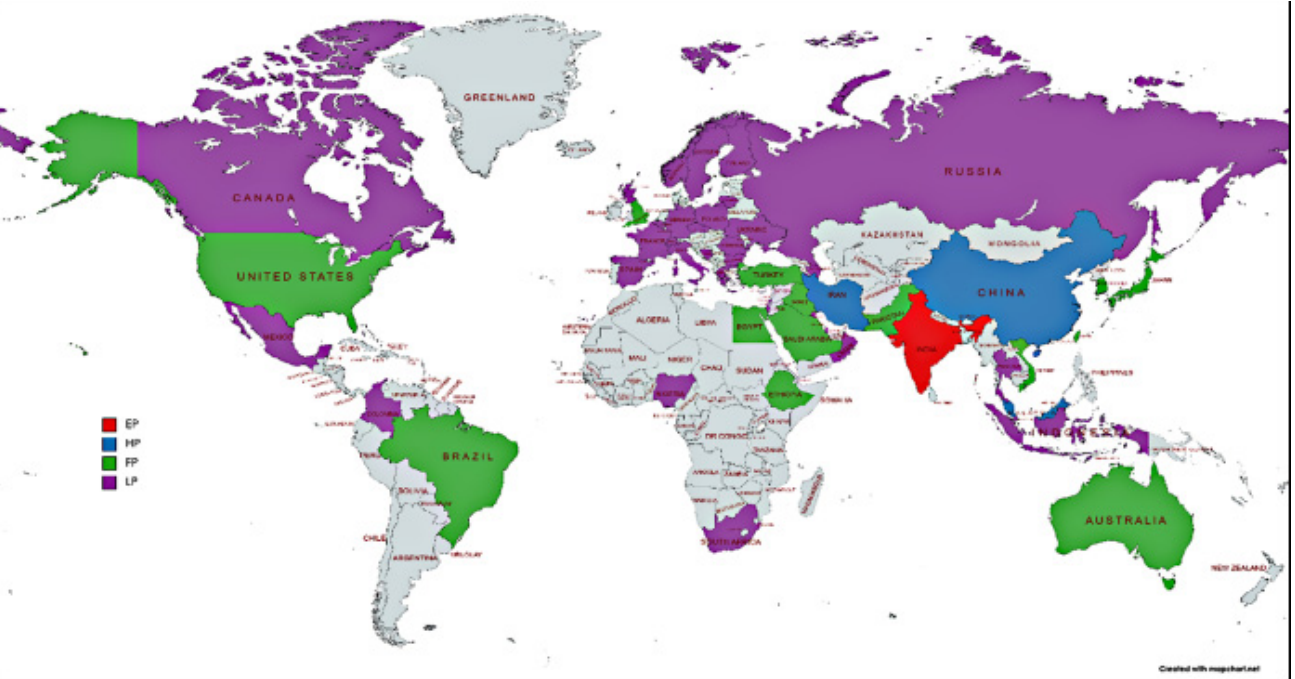
Figure 5. Geographical distribution of research on nanoparticles blending in alcohols/biodiesel/vegetable oil-based fuels (Note—EP: productivity is excellent; HP: productivity is high; FP: productivity is fair/average; LP: productivity is low).